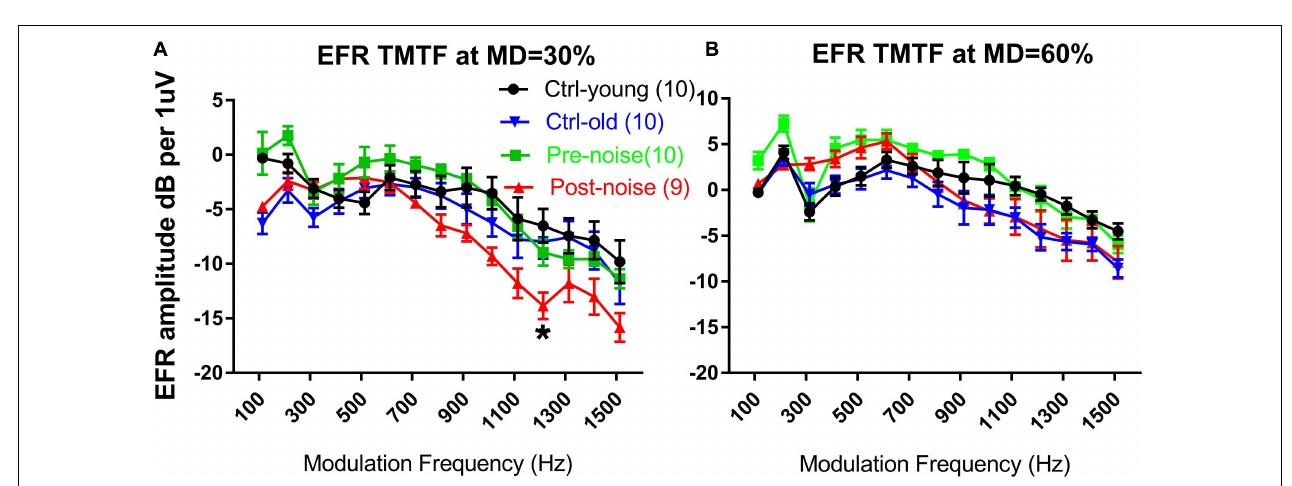
FIGURE 3 | Synapse density comparison across groups ( n = 8 in every group). (A) The cochleogram of synaptic density. (B) The averaged synaptic density in the frequency region above 4 kHz. The synapse density is calculated from ribbons (Ctbp2). Noise 1 refers to a brief noise at 106 dB SPL for 2 h [data taken from a previous study Song et al. (2016)]. Noise 2 refers to the noise exposure examined in the present study (multi-talker noise, repeated over a period of 1 month for 122 h with an Leq of roughly 90 dB SPL). The density was compared between groups. *** p < 0.001, ** p < 0.01.